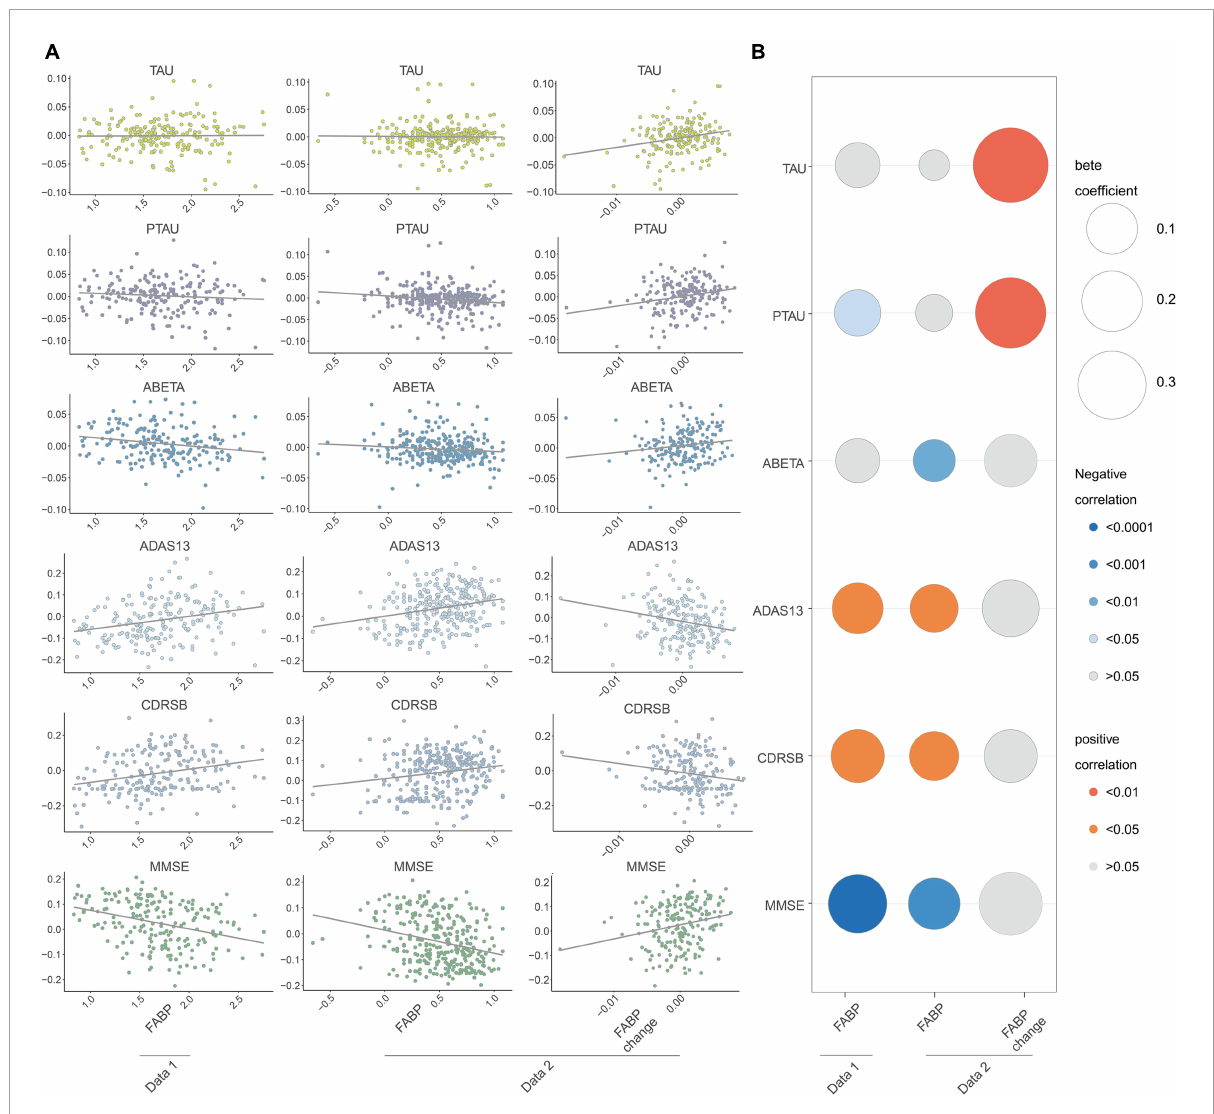
FIGURE2 Longitudinal association between fatty acid binding protein and Mini-Mental State Examination (MMSE), Clinical Dementia Rating sum of boxes (CDRSB), ADAS13, Amyloid beta (ABETA), TAU, and PTAU. (A) Scatter plots of the association of heart fatty acid-binding protein (HFABP) and HFABP change with cognition and AD biomarkers changes; (B) standardized coefficients for the association of HFABP and HFABP change with cognitive measures and AD biomarkers. The size of the bubble represents the correlation levels. The color of the bubble represents the beta coefficient levels (interacted with time). Red: positive correlation. Blue: negative correlation. MMSE, Mini-Mental State Examination; CDRSB, Clinical Dementia Rating sum of boxes; ADAS13, the cognitive section of Alzheimer’s Disease Assessment Scale; ABETA, Amyloid beta; P-tau, phosphorylated